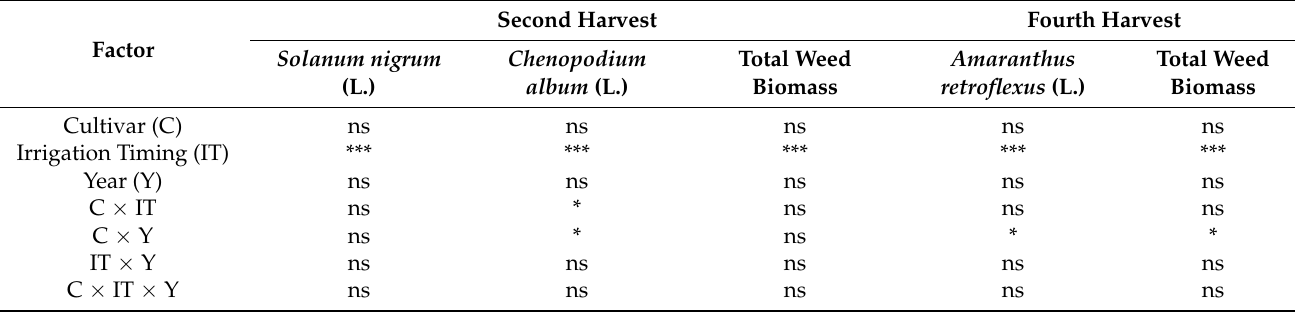
Table 5. The effects of the experimental factors on the weed biomass values recorded, in the second and the fourth harvest, across the two experimental years. Solanum nigrum and Chenopodium album L. were the dominant species during the second harvest. Amaranthus retroflexus L. was the dominant species during the fourth harvest. The p -values were derived from an analysis of